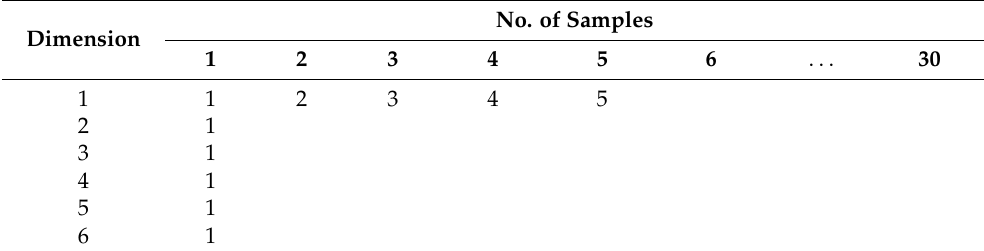
Table 1. The initialization design matrix of position for k = 5 and L = 6. Dimension